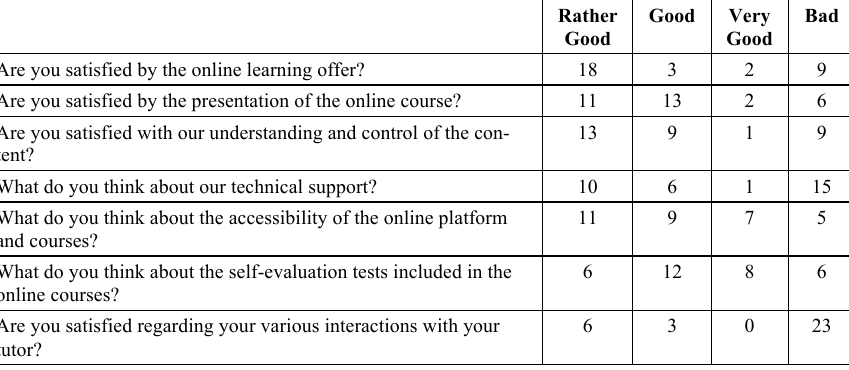
cutting courses in a classical university